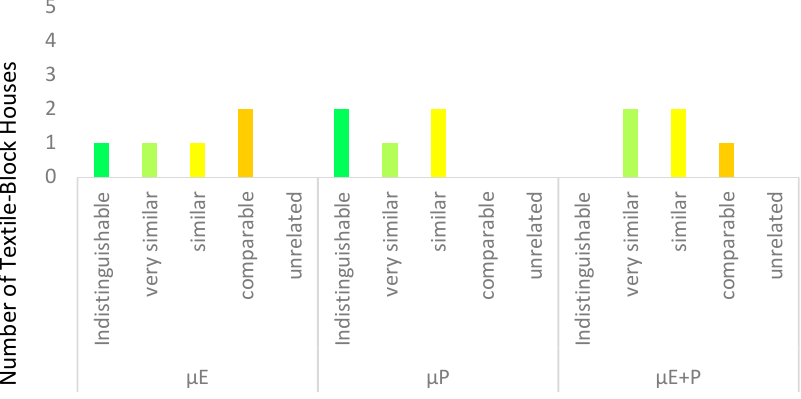
Figure 13. Qualitative comparison of Textile ‐ Block houses and Fallingwater.